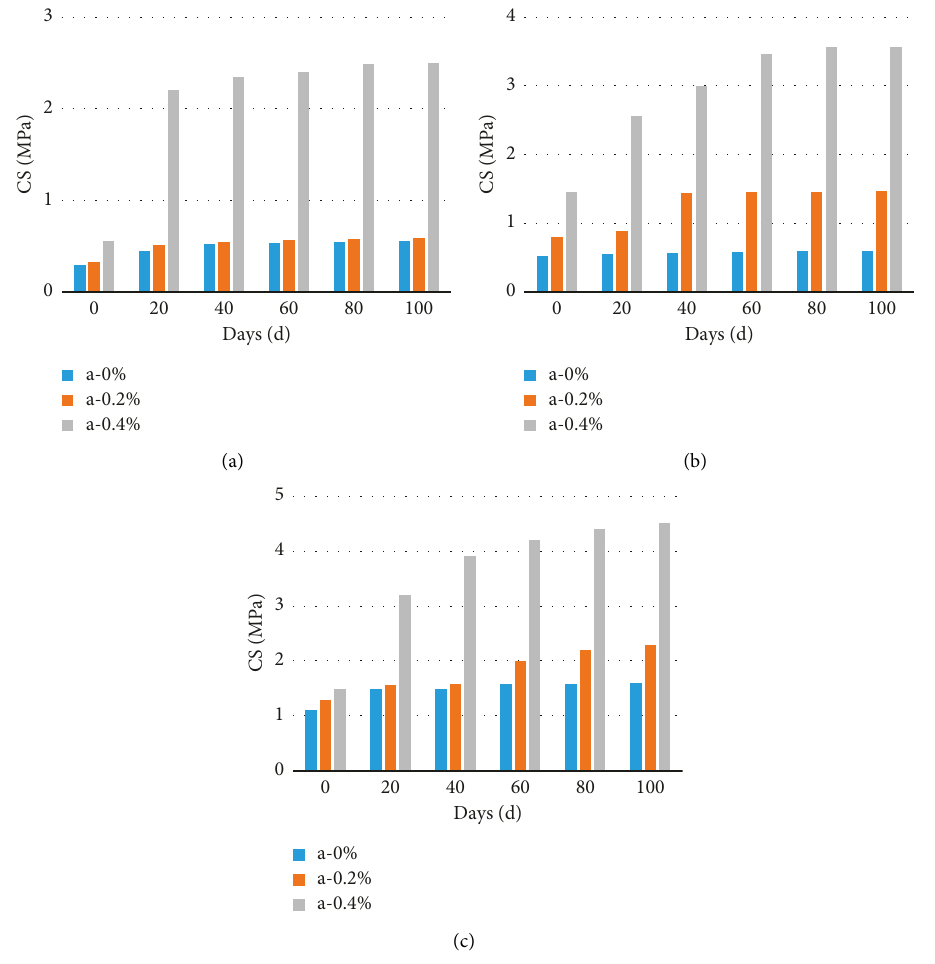
Figure 4: Variation curve of sample compressive strength with age.